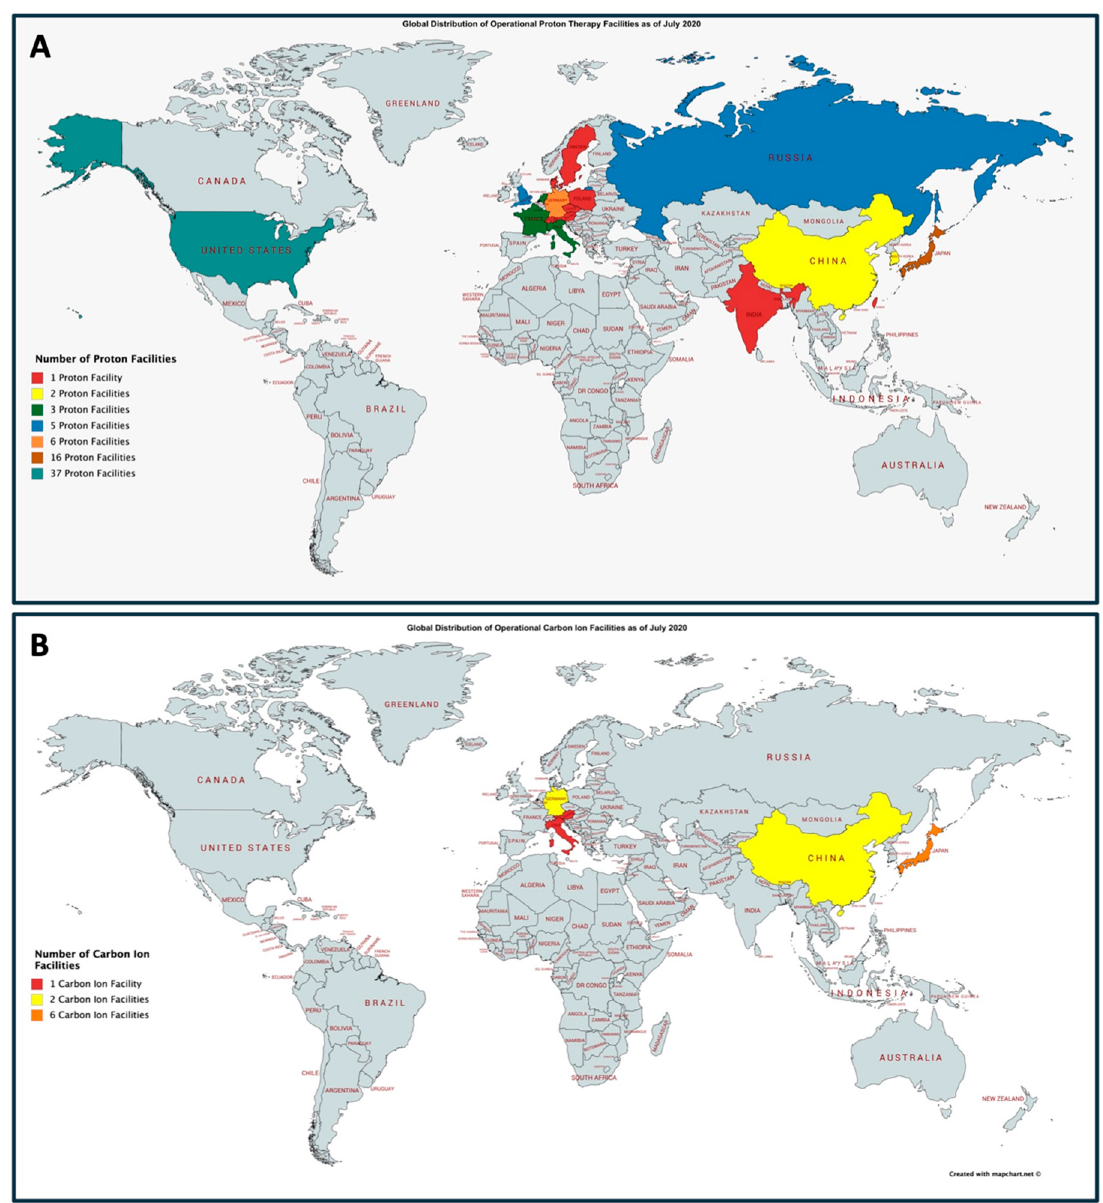
Figure 2. Global distribution of operation proton centers ( A ) and carbon ion centers ( B ) as of July 2020. Presently, there are 90 and 12 operational proton and carbon ion centers, respectively. Adopted from the Particle Therapy Co-Operative Group (https://www.ptcog.ch/index.php/facilities-in-operation). Figures generated using mapchart.net.